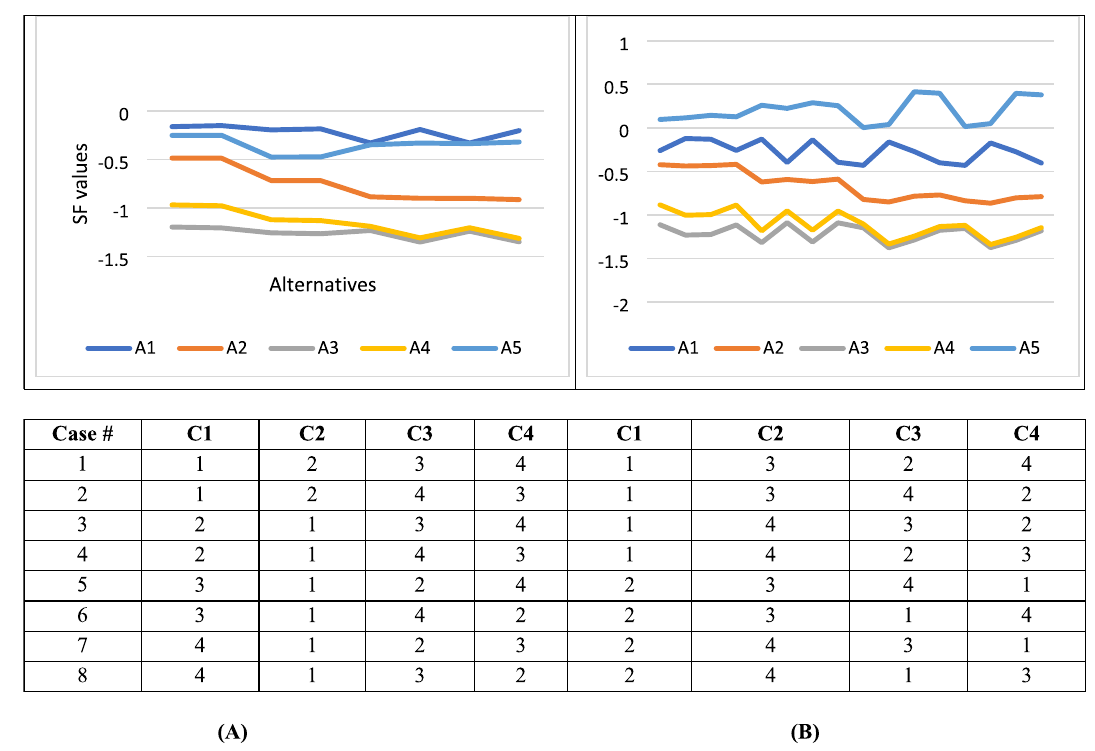
Figure 5. Various priorities of criteria and its impact on alternatives rank from case 1 to